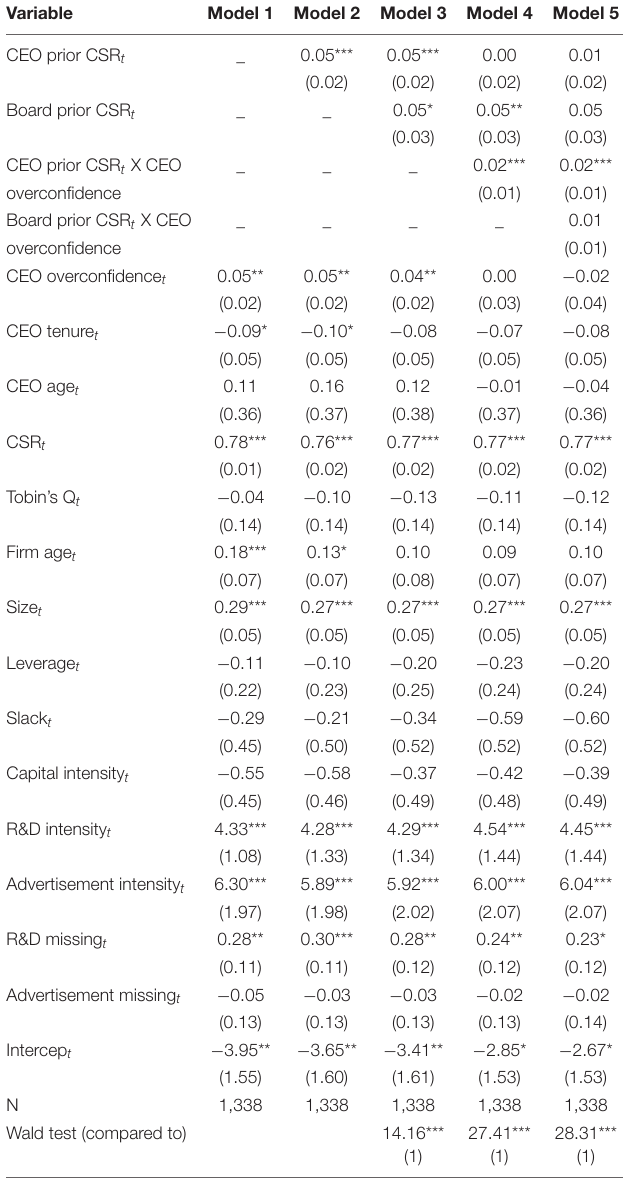
TABLE 3 | Effects of chief executive officer (CEO)/Board prior Corporate Social Responsibility (CSR) on CSR and moderating effects of overconfidence.